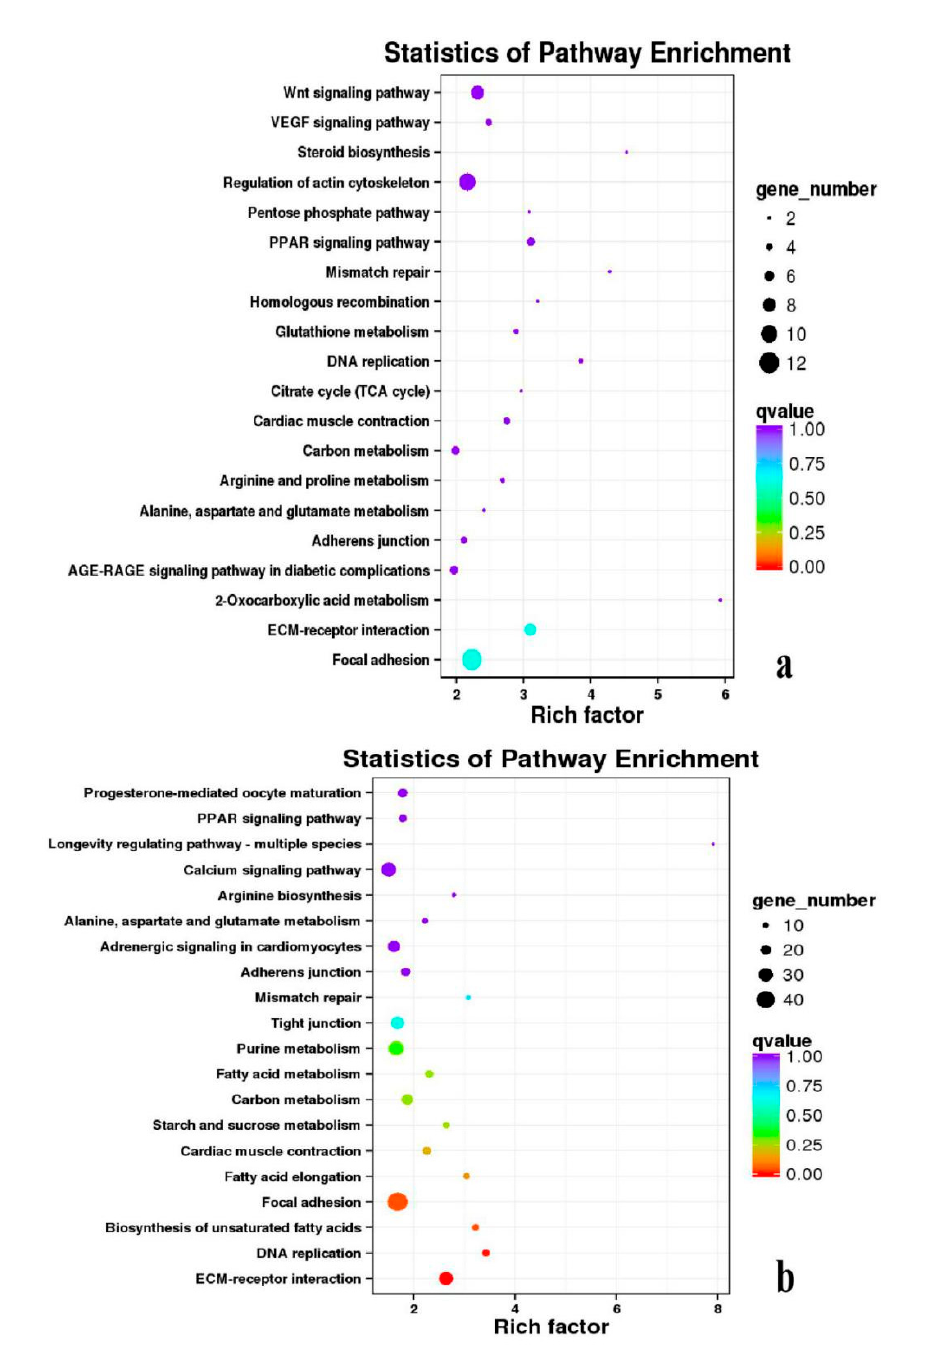
Figure 12. KEGG annotation of DEGs in breast muscle. ( a ) BE17B_vs_BE21B; ( b ) BE17B_vs_BE27B. Note: In the figure, each circle represented a KEGG pathway, name of which was shown on the left legend. Abscissa was enrichment factors, showing the proportion of ( a ) to ( b ), ( a ) was the ration of differentially expressed genes in the pathway with all DEGs in all pathways, ( b ) was the ration of genes in the pathway with all genes in all pathways. The bigger the Rich factor is, the more significant the pathway is. The color of circle represented q value which is adjusted p value by multiple hypothesis testing. Thus, the smaller the q value is, the more significant the pathway is; the circle size represented the number of di ff erentially expressed genes annotated with the pathway, the bigger circle size is, the higher number of genes is. The same